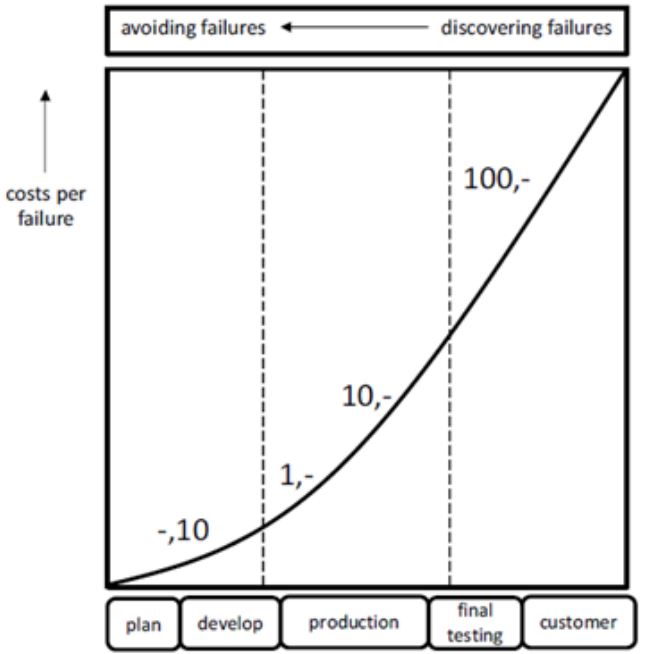
Figure 1. Cost per failure that increase logarithmically at different development stage (Würtenberger et al.,